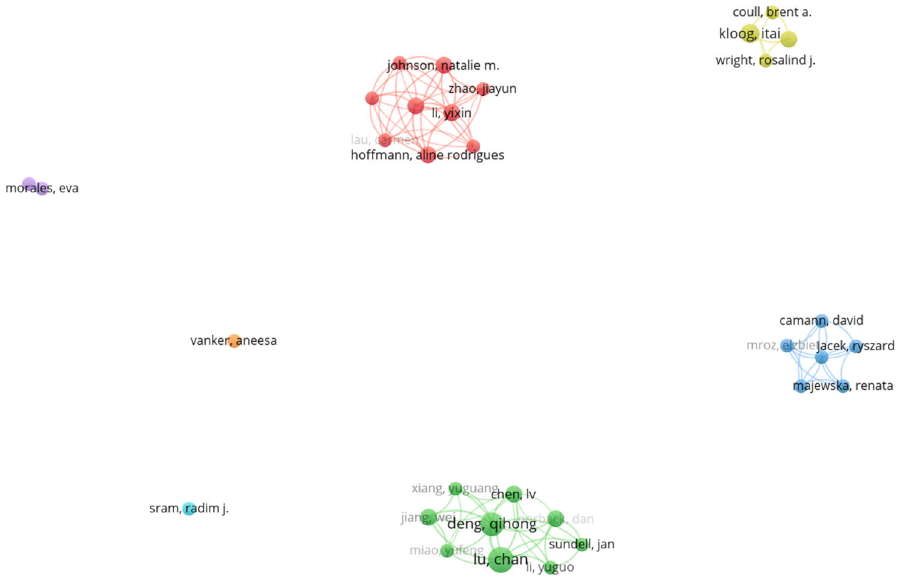
Figure 6. Co ‐ authorship analysis